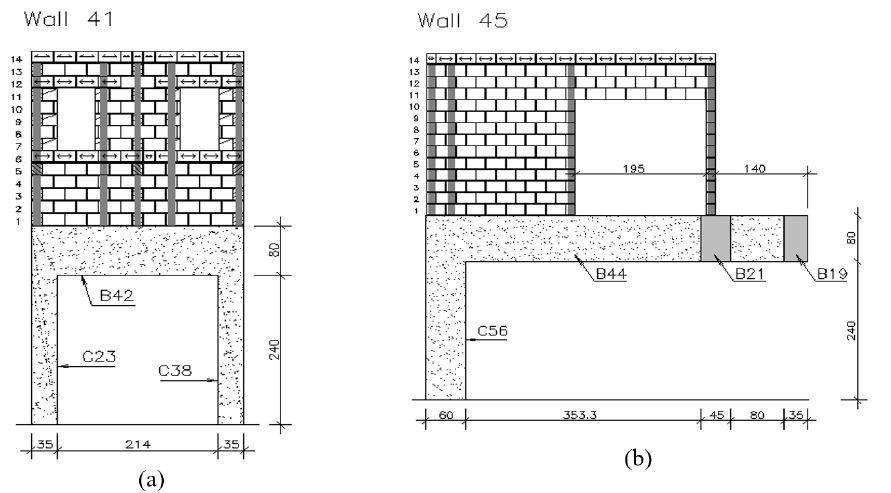
Figure 8. Wall’s elevations: (a) Wall 41; (b) Wall